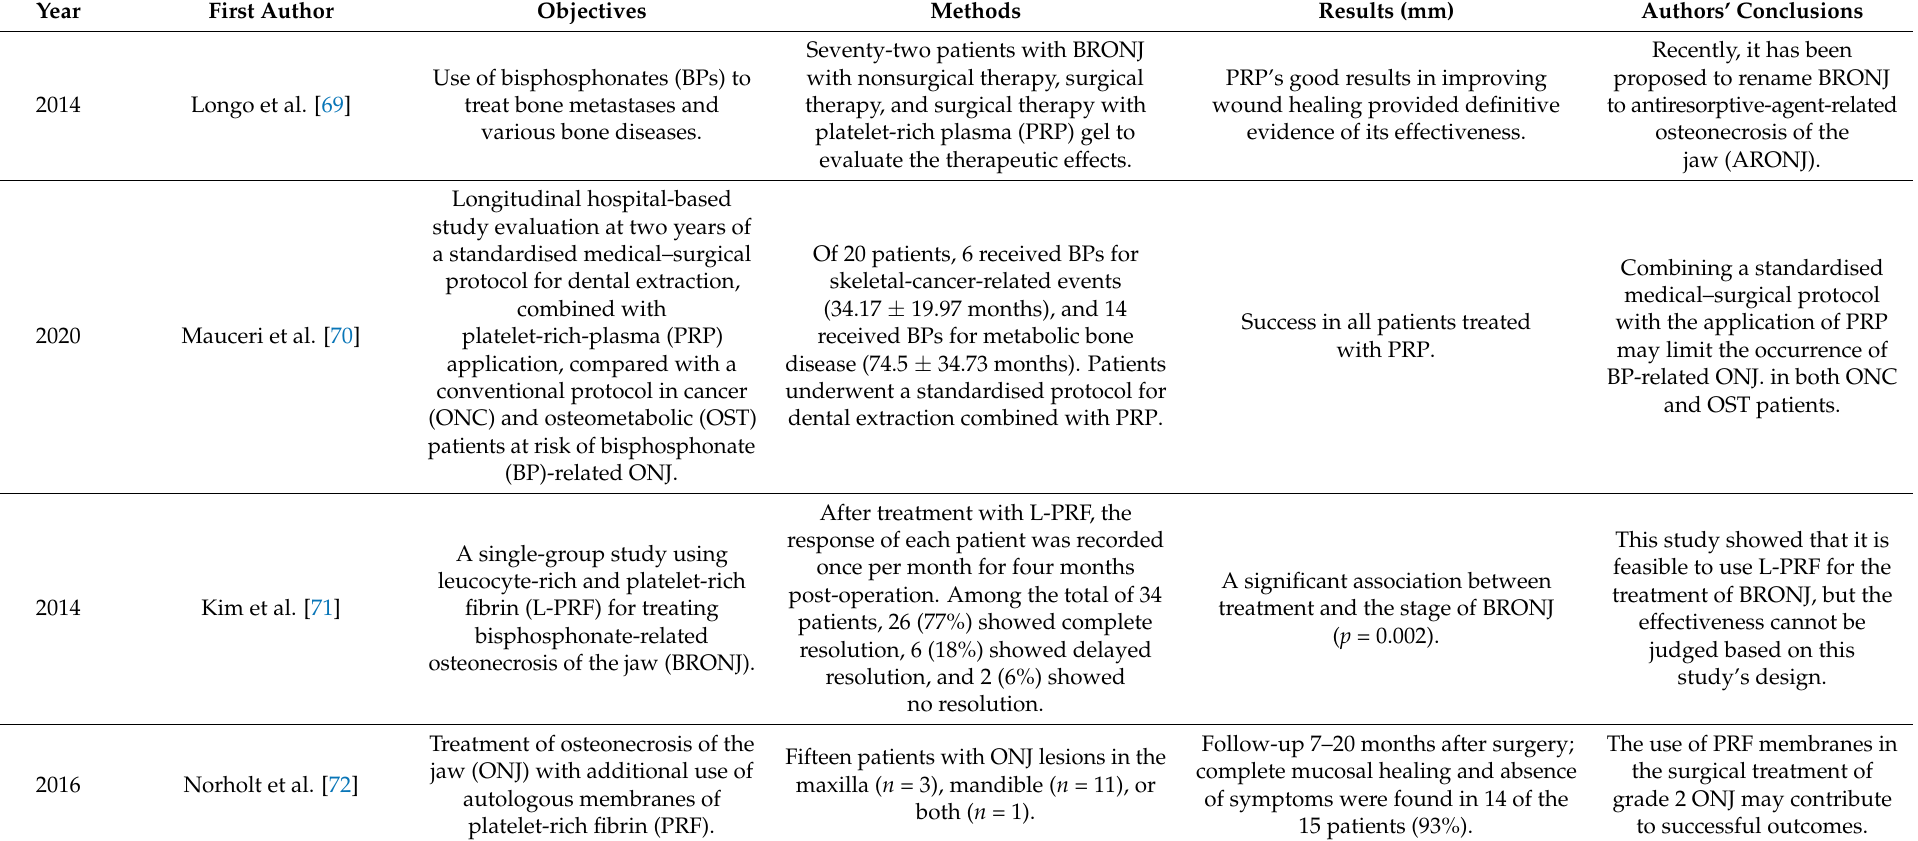
Table 5. Comparison between the 3 APC techniques (PRP, PRF, and CGF) in